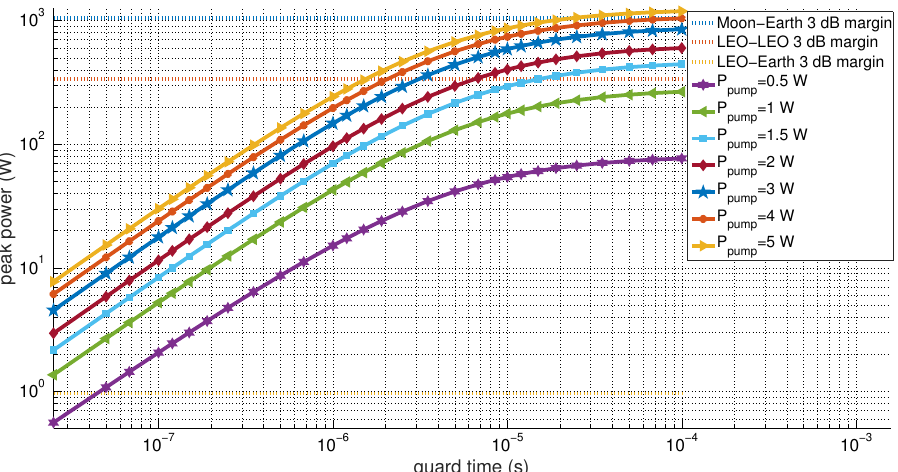
Figure 16. The simulated transmitted peak power for the MOCT EDFA design. The transmitted peak power is shown as a function of guard time for a few select pump optical powers: 0.5 W, 1 W, 1.5 W, 2 W, 3 W, and 4 W. A pump power of 5 W is also included for comparison. A transmitter optics loss